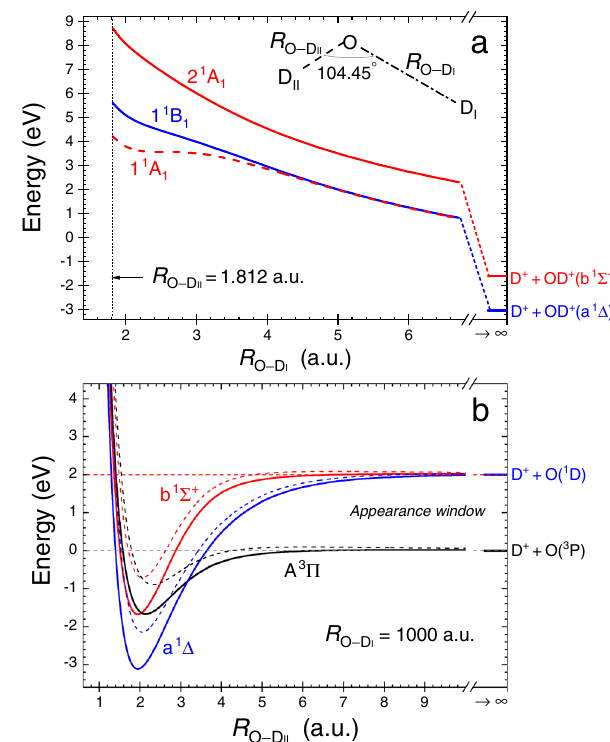
R Þ , at the O (cid:2) D II I =1000a.u.), I